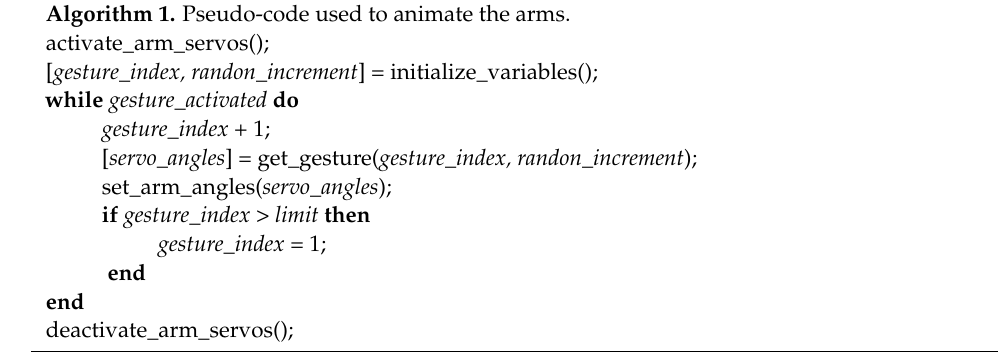
Algorithm 1. Pseudo-code used to animate the